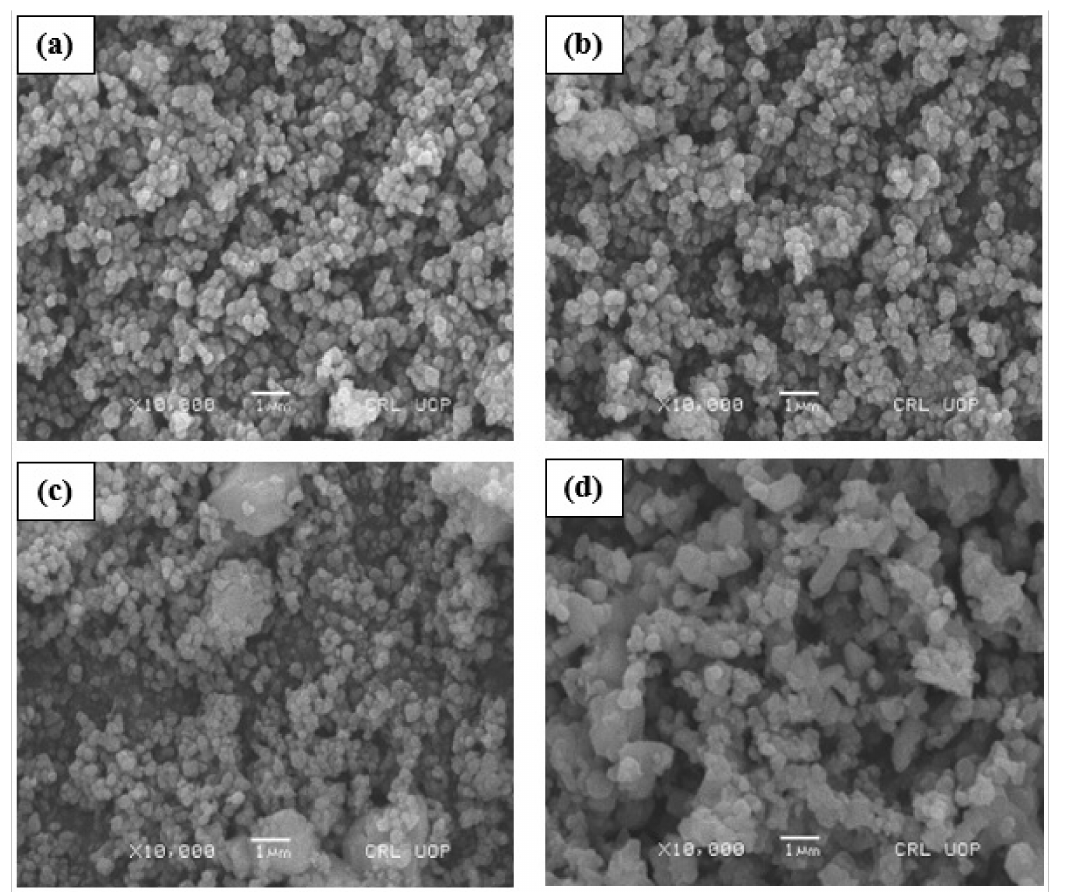
Figure 3. SEM images of polished & thermally etched samples of (Sr 1 − x Ca x ) 5 Ti 4 O 13 , 0 ≤ x ≤ 0.06 sintered ceramics ( a ) x = 0.00, ( b ) x = 0.02, ( c ) x = 0.04 and ( d ) x =